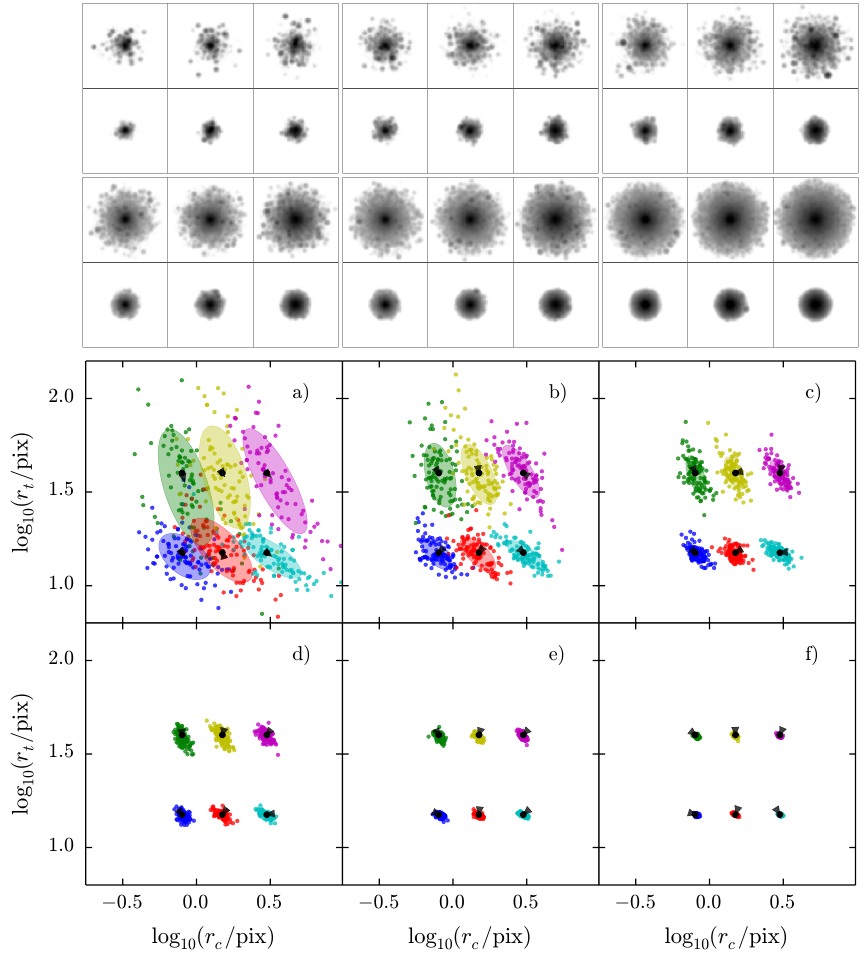
Fig.3. The same as in Fig.1, but for 1 Gyr